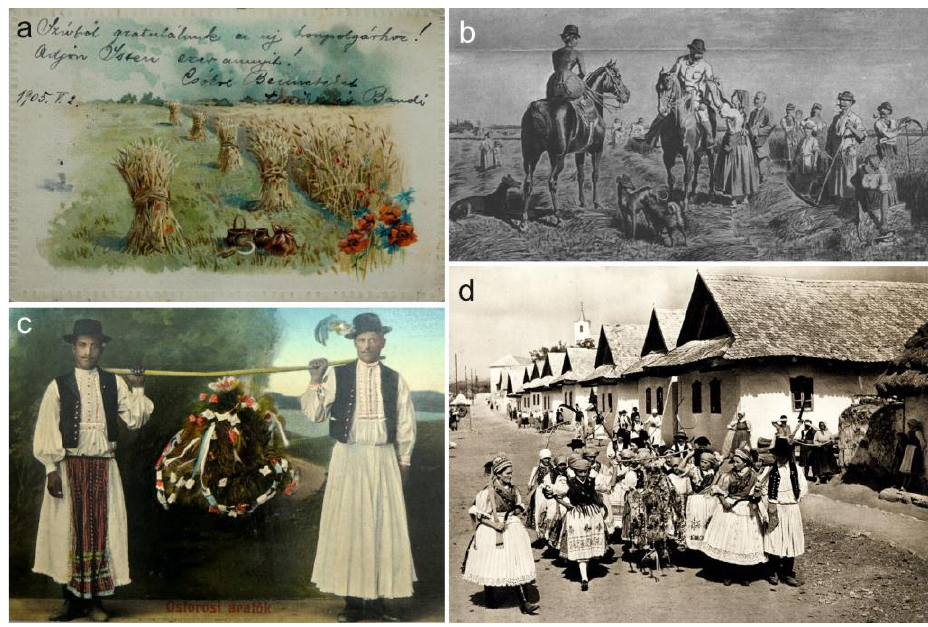
Figure 5. The studied species in historical artworks: ( a ) cereal sheaves with corn poppy and corn- flower (postcard with good wishes for a newborn baby from May 1905, collection of Gyula Pinke); ( b ) ceremonial binding of the landlord (drawing by Mihály Szobonya, source: Vasárnapi Ú jság, 1888, 35 (28): 457; ( c ) harvesters with a harvest wreath (postcard, Ostoros, N Hungary, 1910 – 1920, © Zempléni Múzeum); ( d ) harvest festival (Kazár, N Hungary, 1940. Photograph by Géza Buzinka, courtesy of